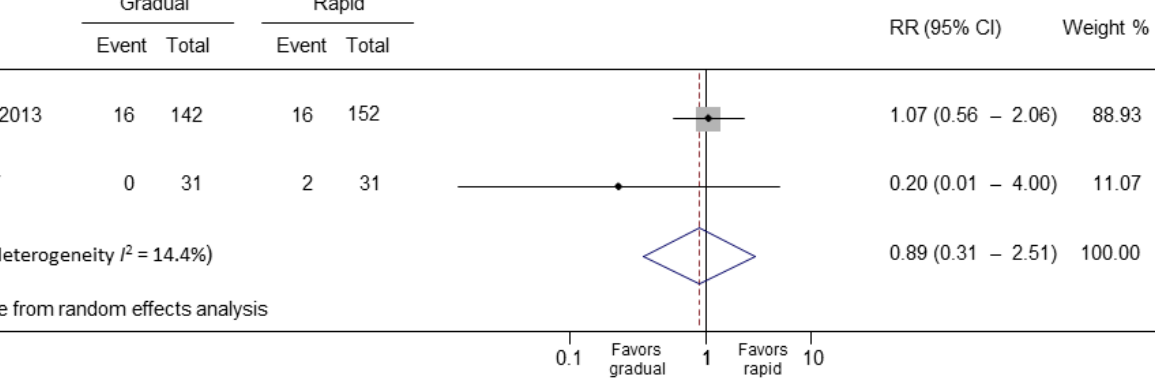
Figure 3. Forest plot of randomized controlled studies. RR, relative risk; CI, confidence interval.